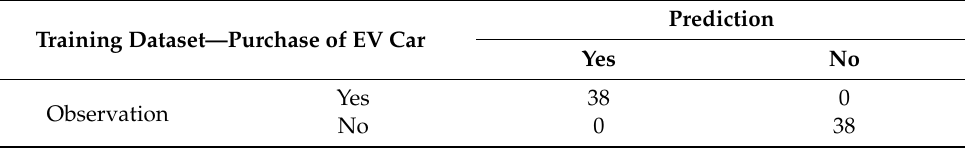
Table 4. Training dataset—purchase of EV car—prediction and observation.